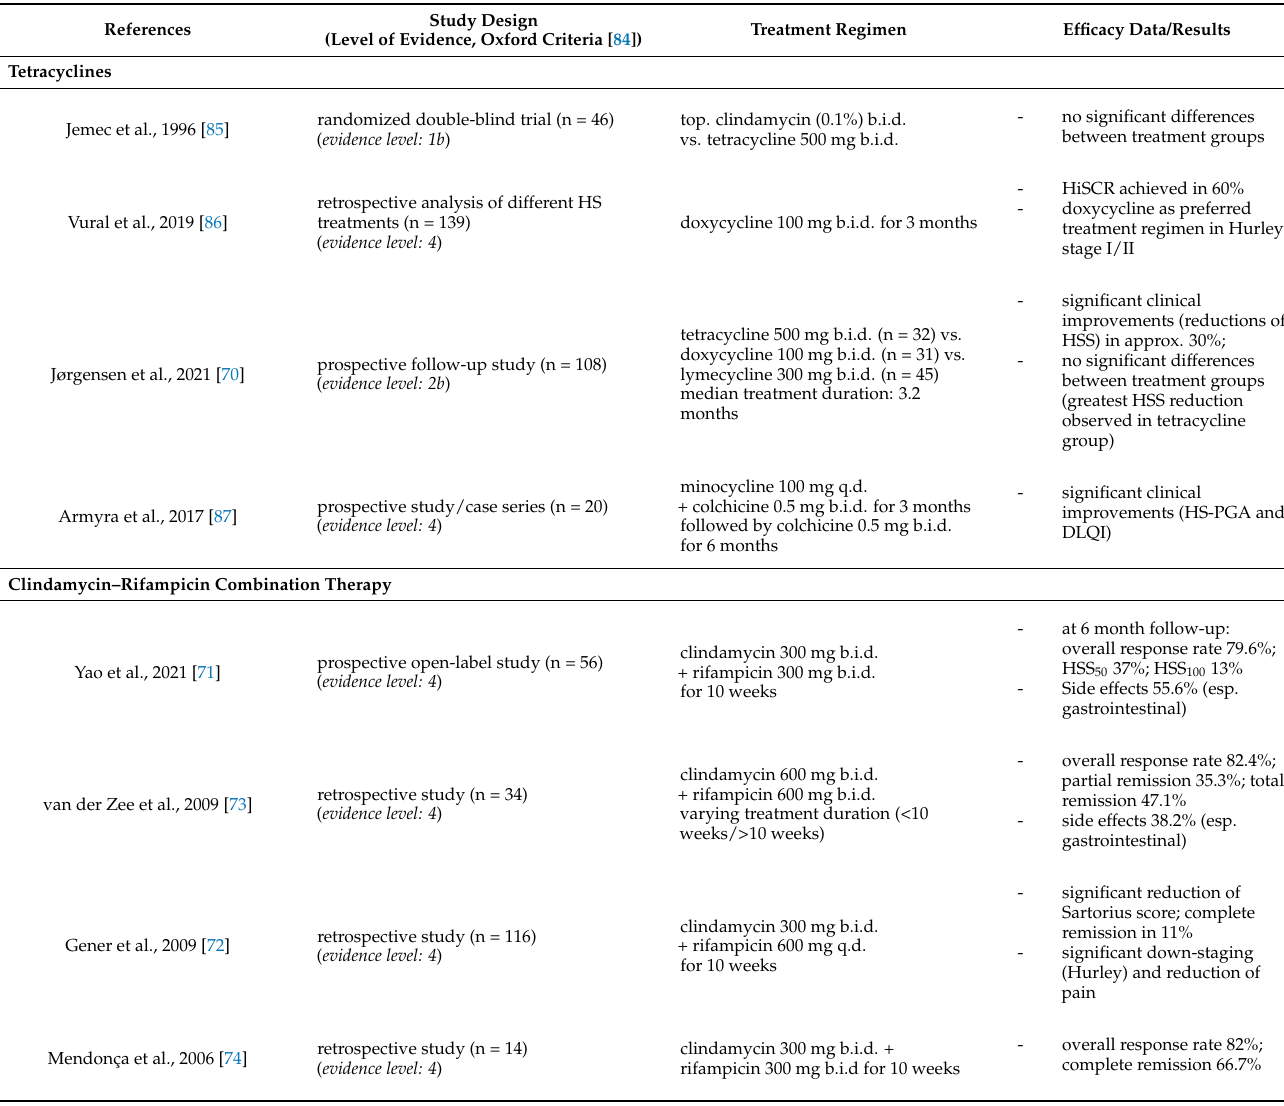
Table 1. Overview of systemic antibiotic regimens in clinical studies.